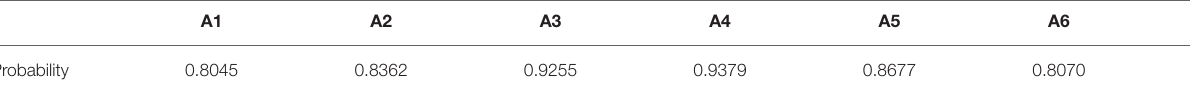
TABLE 8 | Classification accuracy based on the attribute